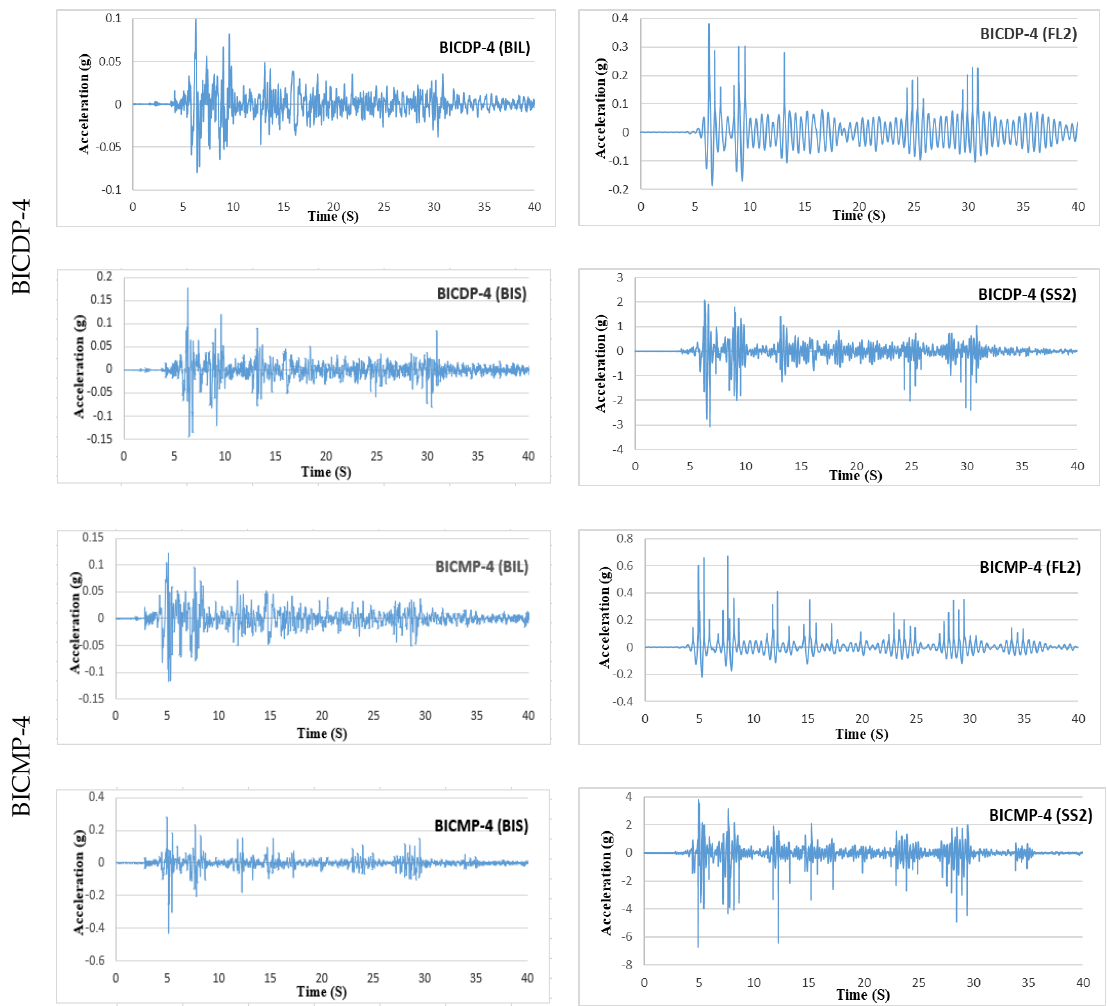
Figure 9. Responses of DP and MP between flexible and stiffer models. Table 9. Maximum response in a combination of different frequency models.